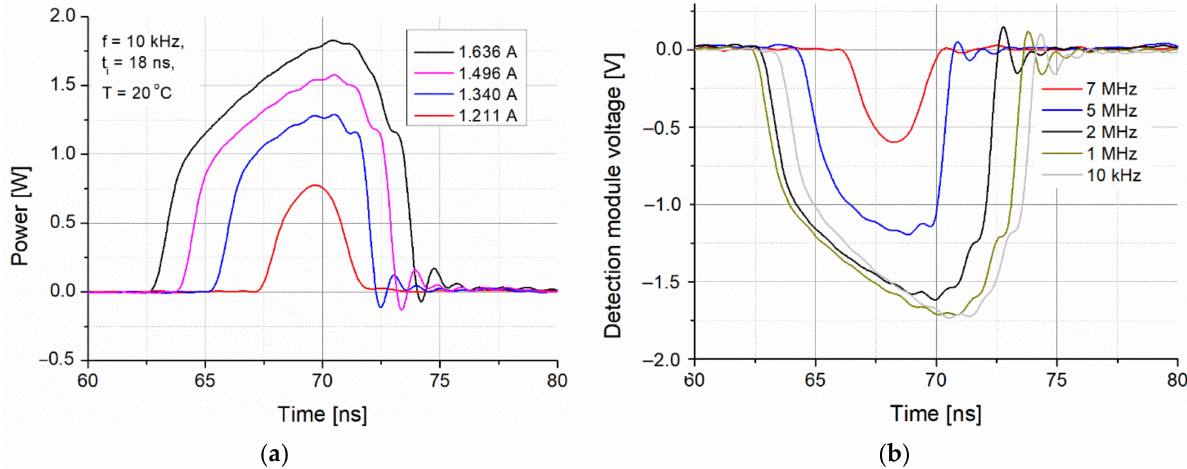
Figure 9. ( a ) Power of optical signals for different driving currents and ( b ) shapes of light pulses for different driving